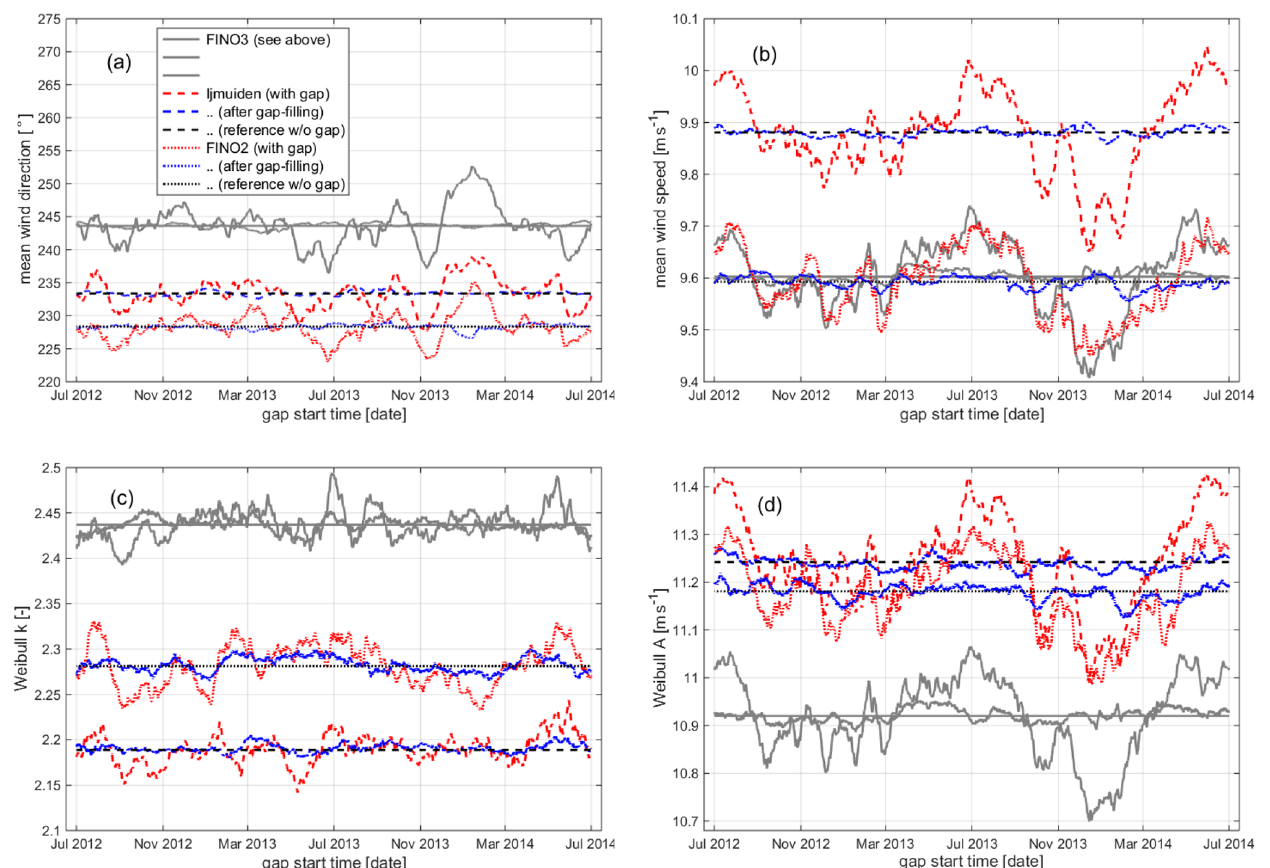
Figure 8. Variation in statistical measures – (a) mean wind direction and (b) mean wind speed and Weibull (c) shape and (d) scale parameters, A and k , respectively – depending on the start date of the artificial gap, here for a gap length of 30d as in Fig. 6. Results for FINO3 (already presented above) as solid grey lines, for IJmuiden as dashed lines and for FINO2 as dotted lines (again for incomplete time series in red and for filled time series in blue and wind statistics for the original time series in